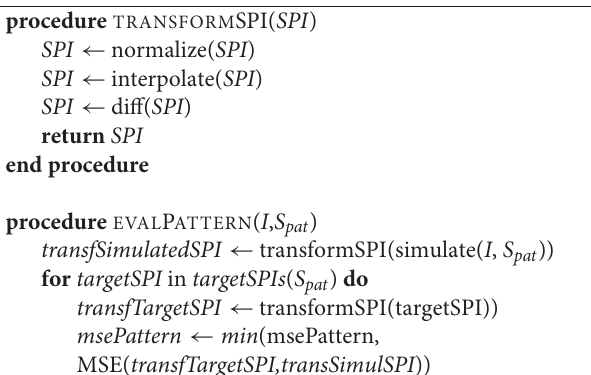
Algorithm 1 | Pseudocode of the fitness function, which